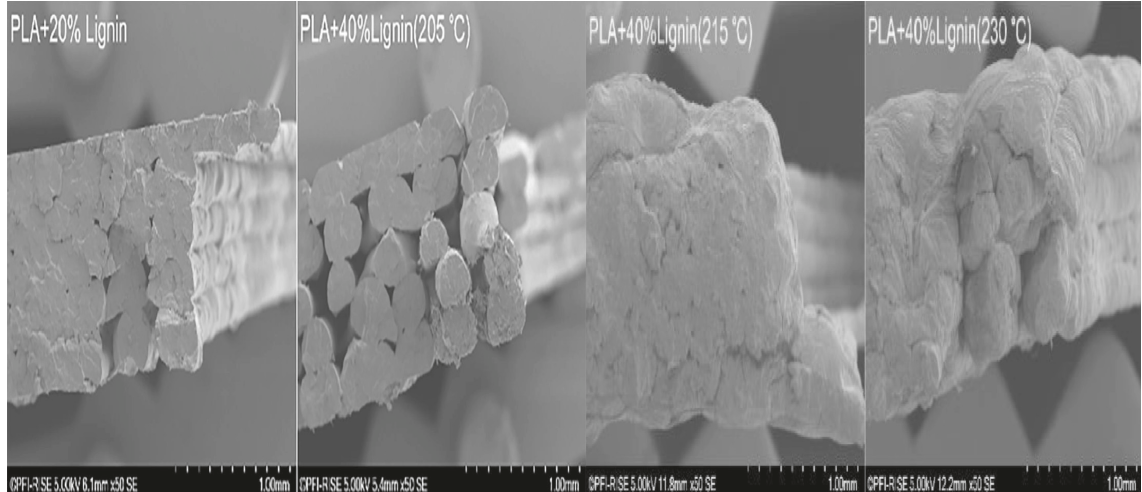
Figure 10: SEM images of lignin-based biocomposites at different temperatures [227] (Copyright @ 2019 MDPI under CC BY